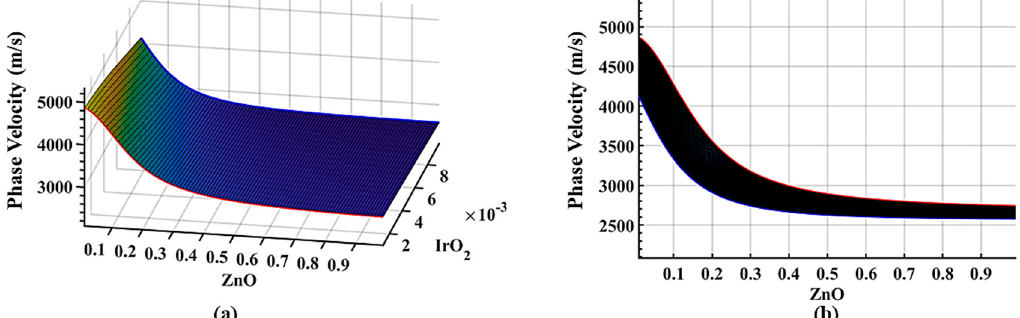
Figure 2. Dispersion surface plots of the three-layer system with a quartz substrate as the first layer, ZnO guided layer as the second layer, IrO 2 guided layer as the third layer, and no liquid layer at 100 MHz with relaxation time, ωτ = 10 6 , showing ( a ) a phase velocity plot in isometric view; and ( b ) a plot of phase velocity vs the variation of ZnO layer thickness.